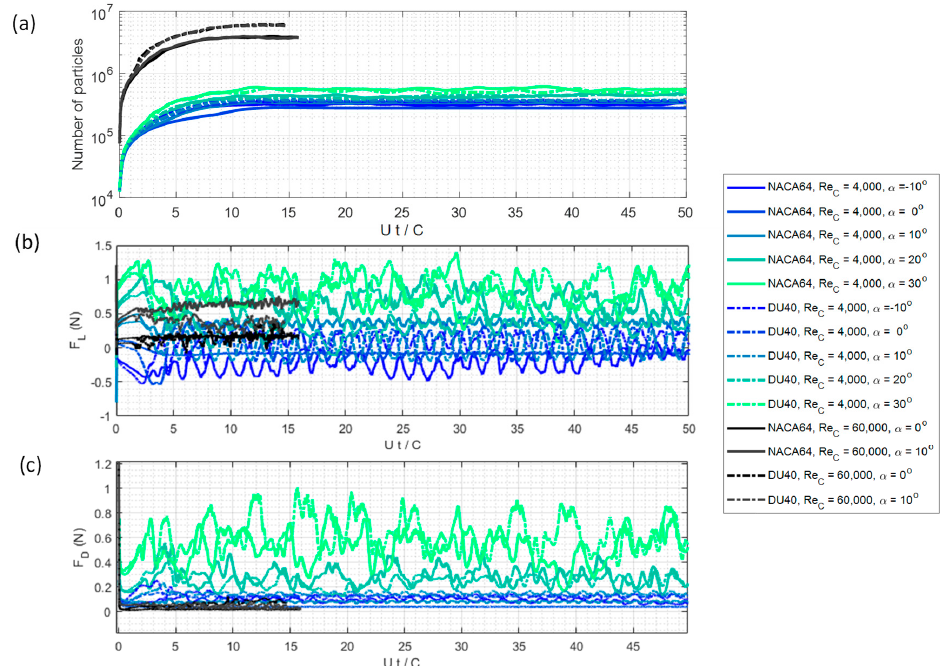
Figure 3. Time evolutions of flow quantities: ( a ) Numbers of particles used in simulations. ( b ) Lift force. ( c ) Drag force. force. ( c ) Drag